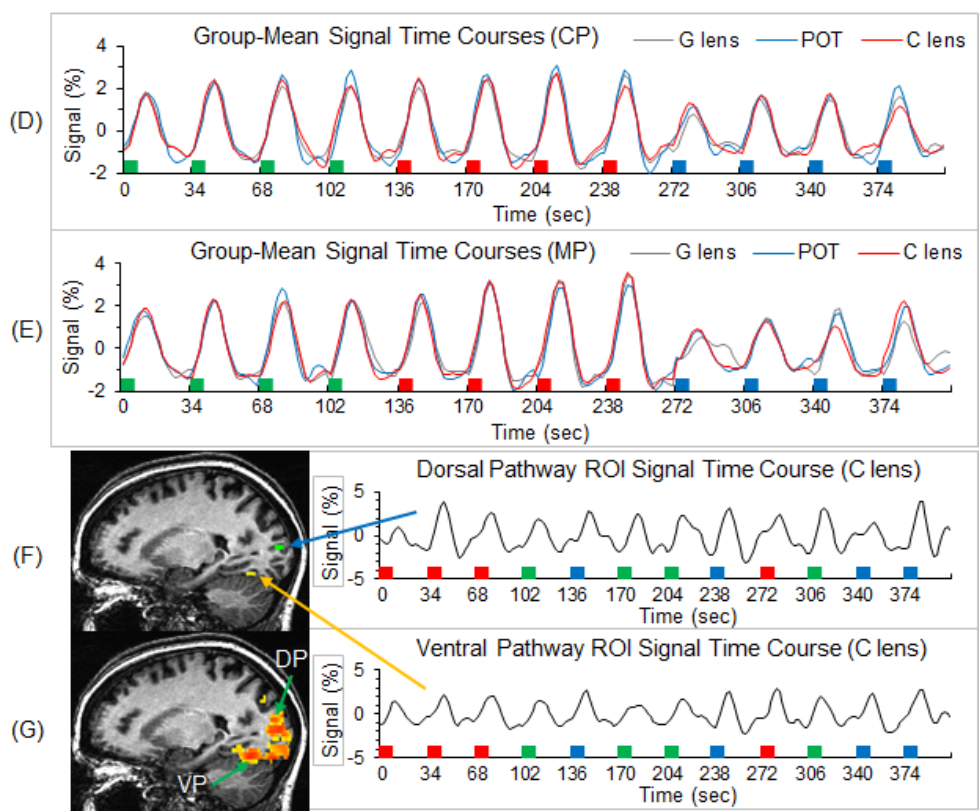
Figure 3. Illustration of the three selected stimulation-associated FAUPAs in area V1 in the original space and their corresponding signal time courses for a representative participant, and the group-mean signal time courses of the selected FAUPAs for the three lens types and two participant groups. Top three panels ( A – C ): the green arrow points to small red clusters in the left images, which represent the selected stimulation-associated FAUPAs in area V1 for the three lens types, respectively. The yellow voxels represent the overlapped area across these three FAUPAs. For each FAUPA, the right plot shows its signal time course averaged over all voxels within that FAUPA. For each time course, the magnitude represents the percentage signal change relative to the mean signal of the time course. In each plot, the two blue arrows indicate a noticeable variation in the BOLD response for the same stimulus. The green, red, and blue bars represent the onset and duration of the three striped patterns with SF of 0.31, 2.5, and 7.9 cpd, respectively. CS: calcarine sulcus; ( G ): gray; POT: precision ophthalmic tint; (C): color. Middle two panels ( D , E ): for each of the two participant groups, the plot shows the group-mean signal time courses of the selected FAUPAs for the three lens types, respectively. Note that, as the stimuli were presented in a pseudo-random order in each scan, for computing the group-mean signal time course for each lens type and each group, the signal time course of each selected FAUPA was first sorted according to the SFs and then averaged over all participants within the group. CP: control participants; MP: migraine patients. Bottom two panels ( F , G ): illustration of the visual stimulus-processing network along both the dorsal and ventral pathways for the representative participant. One green region of interest (ROI) with 4 voxels was placed on the dorsal pathway (DP), and one yellow ROI was placed on the ventral pathway (VP) (top left image). The right two plots show the ROI-mean signal time course for these two ROIs indicated by the blue and yellow arrows. The colored clusters in the bottom left image show the R map with threshold R > 0.5, i.e., the visual stimulus-processing network.